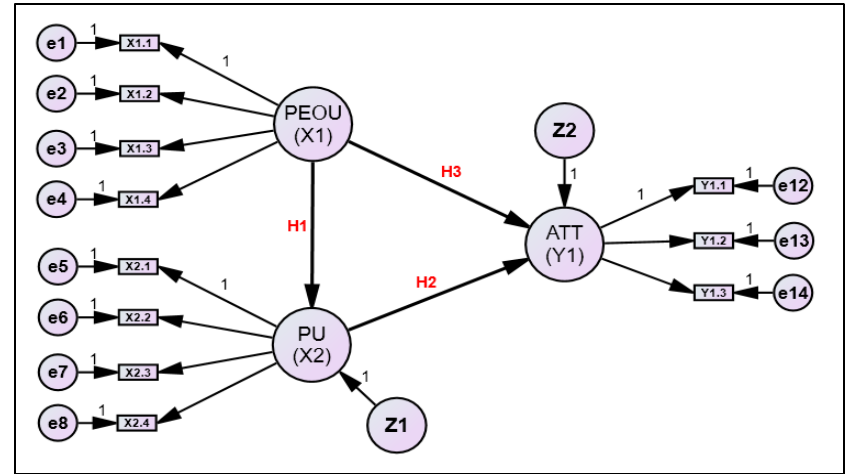
Figure 2. Flowchart of Causality Relationships